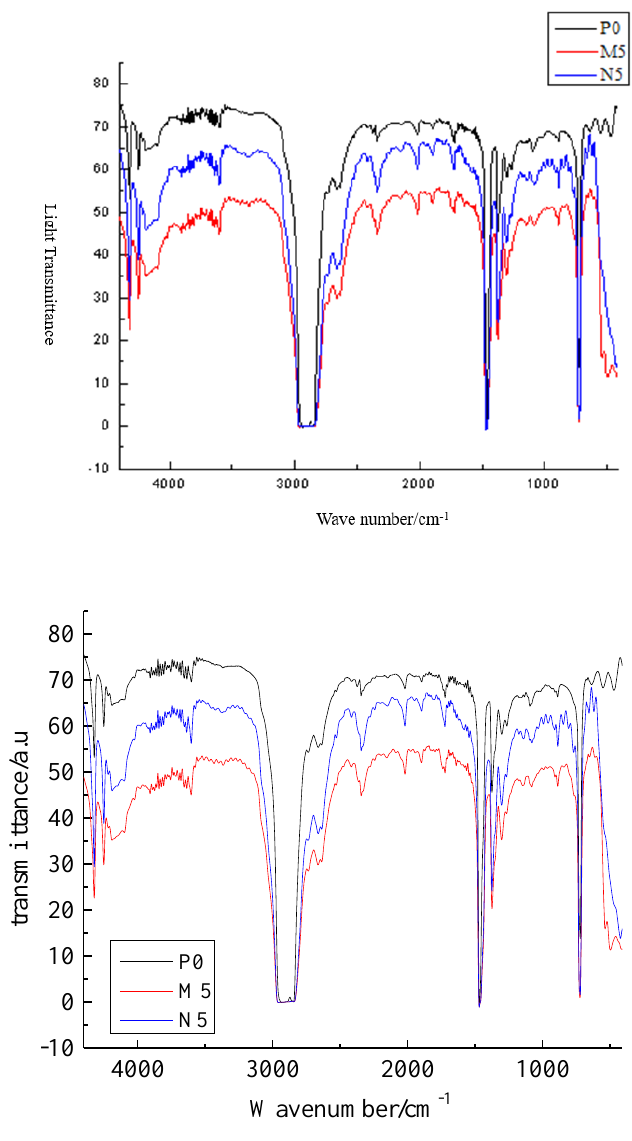
Figure 3. FTIR pattern of different samples.